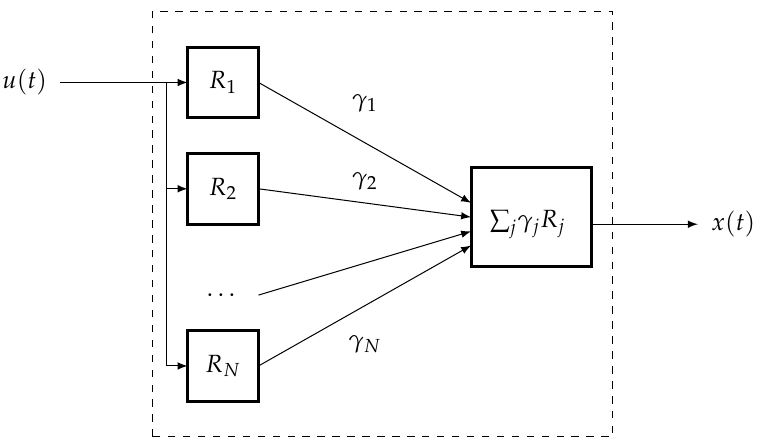
Figure 7. The parallel connection of N relay R j [ α , β , x 0 , t 0 ] , taken with weights γ j > 0, where j = 1, . . . , N